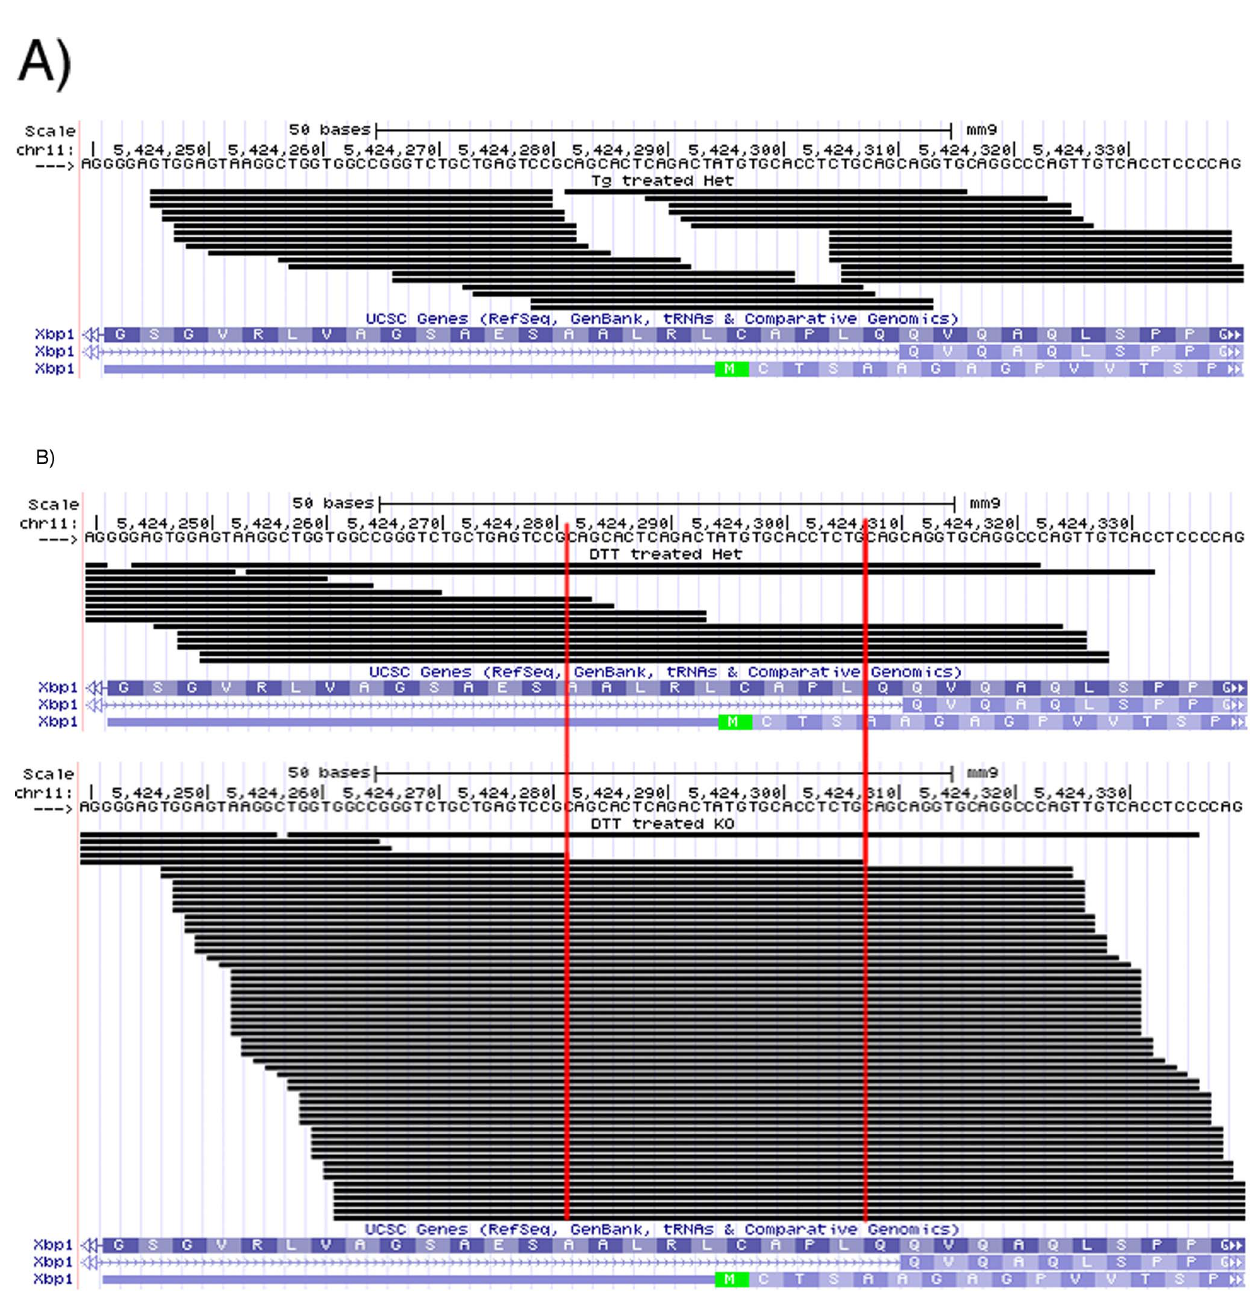
Figure 3. UCSC custom track view for Xbp1 26 nt spliced region in mouse embryonic fibroblast cells and qRT-PCR results. ‘‘Het’’ = Ire1 a + / 2 ; ‘‘KO’’ = Ire1 a 2 / 2 . a =500 nM Thapsigargin 4 hrs; b =1 mM Dithiothreitol 4 hrs; For both a and b, Het reads are on top and KO reads are on the bottom. Red vertical lines indicate the 26 nt spliced region. doi:10.1371/journal.pone.0100864.g003 PLOS ONE |